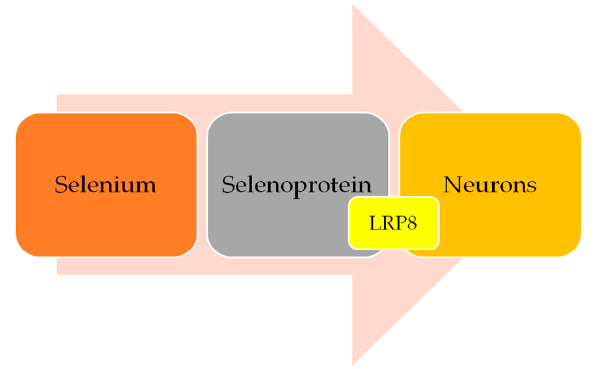
Figure 1. Brain selenium transport mechanism (simplified).